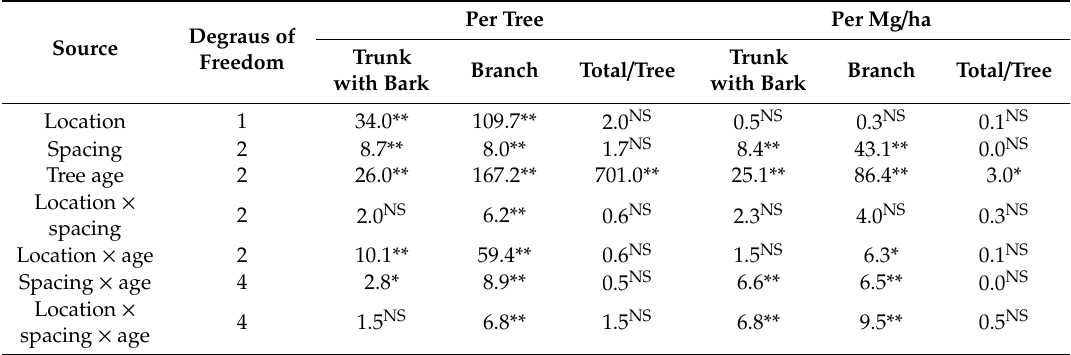
Table 6. F-values from ANOVA of carbon in Gmelina arborea per tree, measured in kg tree − 1 , and per area, measured in Mg ha − 1